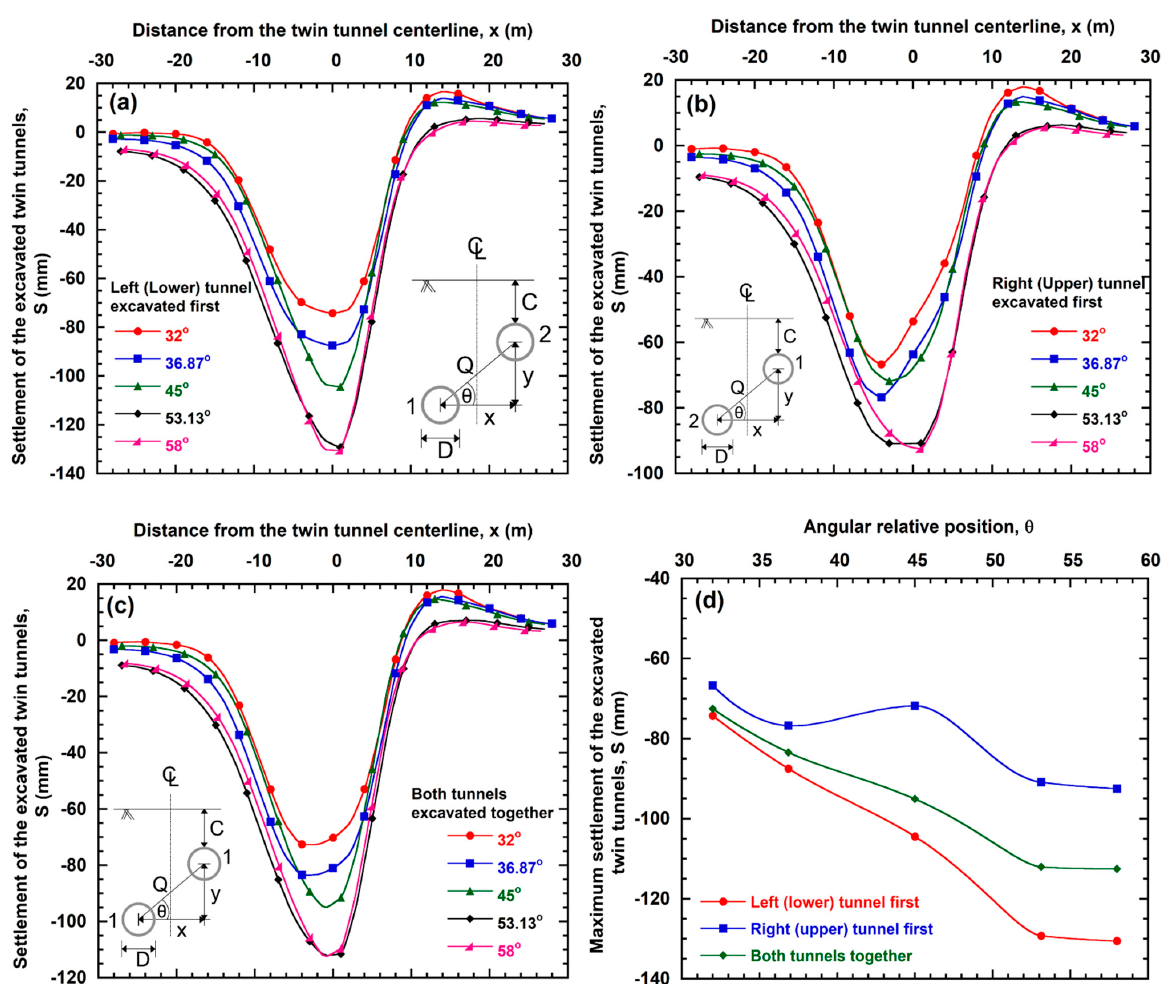
Figure 8. Effect of angular relative position on ( a – c ) combined surface settlement caused by the excavation of offset arrangement twin tunnels and ( d ) maximum total surface settlement of the twin tunnels.